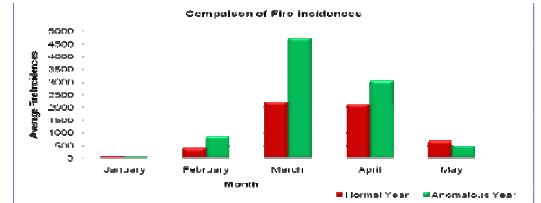
Figure 3: Intra Annual Forest fires in norma during 2003 to 2010 3.2 Variability of air temperature and probable forest fire incidences This correlation has been generated fro (including normal and anomalous years) o against the average air temperature of the 7y